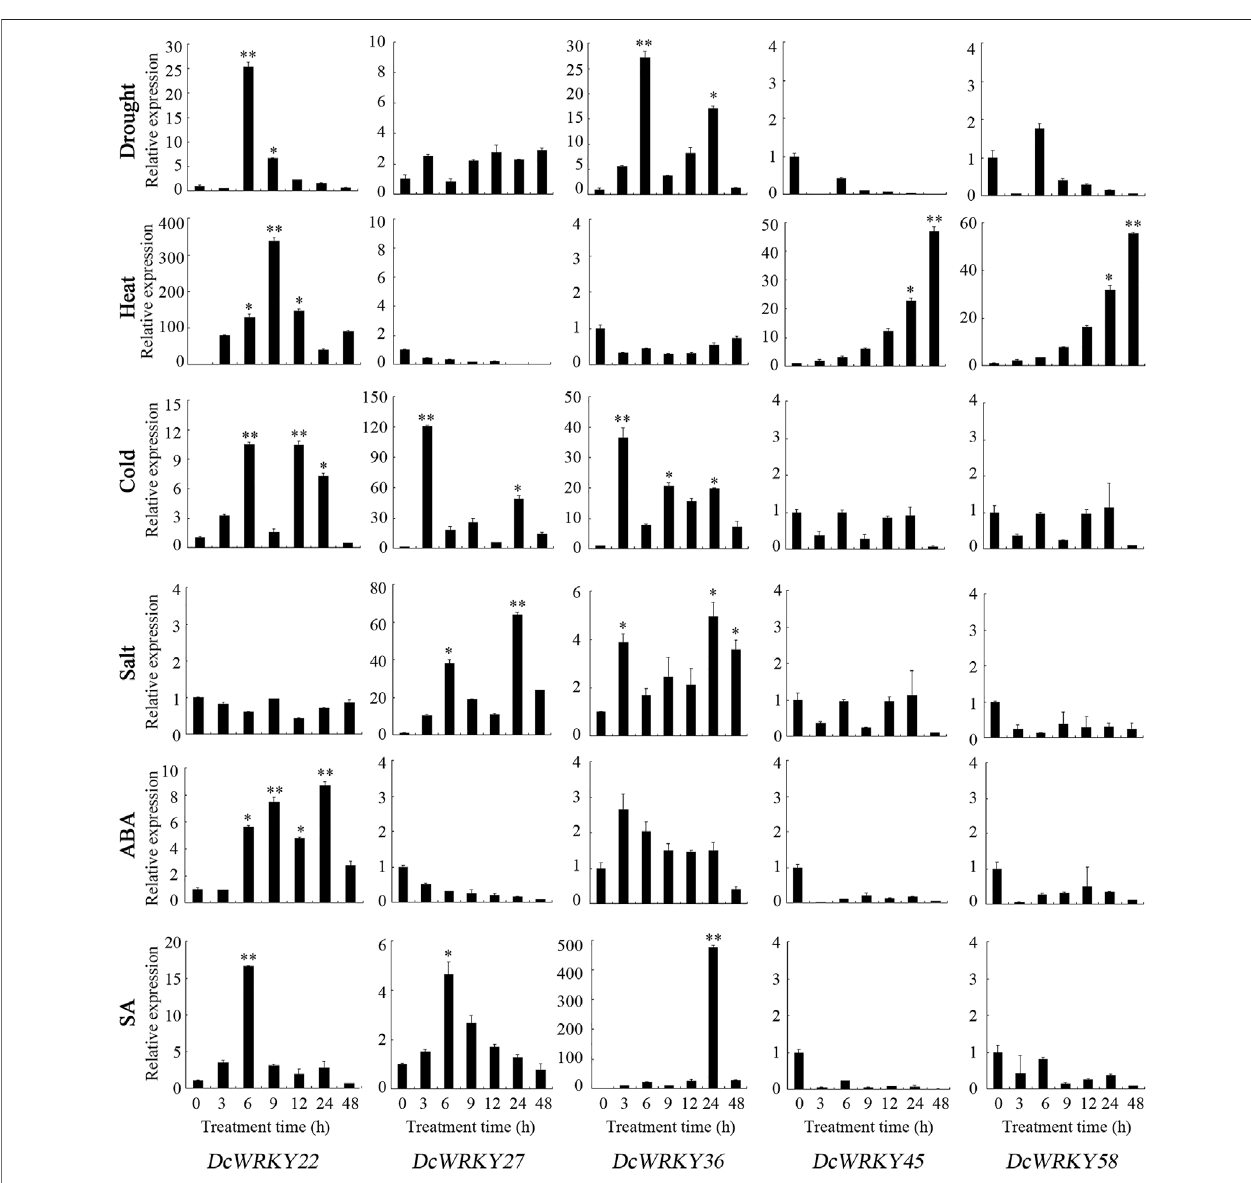
FIGURE 5 | Real-time quantitative PCR analysis of 5 DcWRKY genes under abiotic stress and hormone treatment in roots. Vertical bars indicate the standard deviation ( n = 3). Values of 0, 3, 6, 9, 12, 24, and 48 indicate hours after treatment. The unstressed level (0 h) was used as a control. Asterisks ( p or pp ) indicate a signi fi cant difference at p < 0.05 or 0.01,